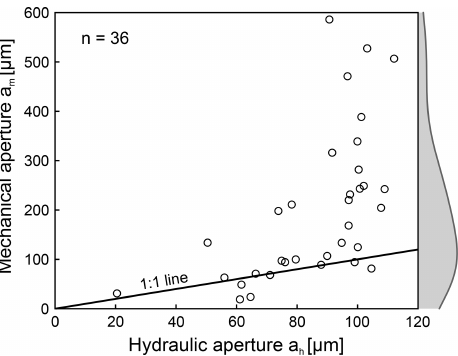
Figure 4. Comparison of measured mechanical and hydraulic frac- ture apertures in the EZ-B niche with probability density function for a m . Two outliers with mechanical apertures of 789 and 833µm are not shown for better